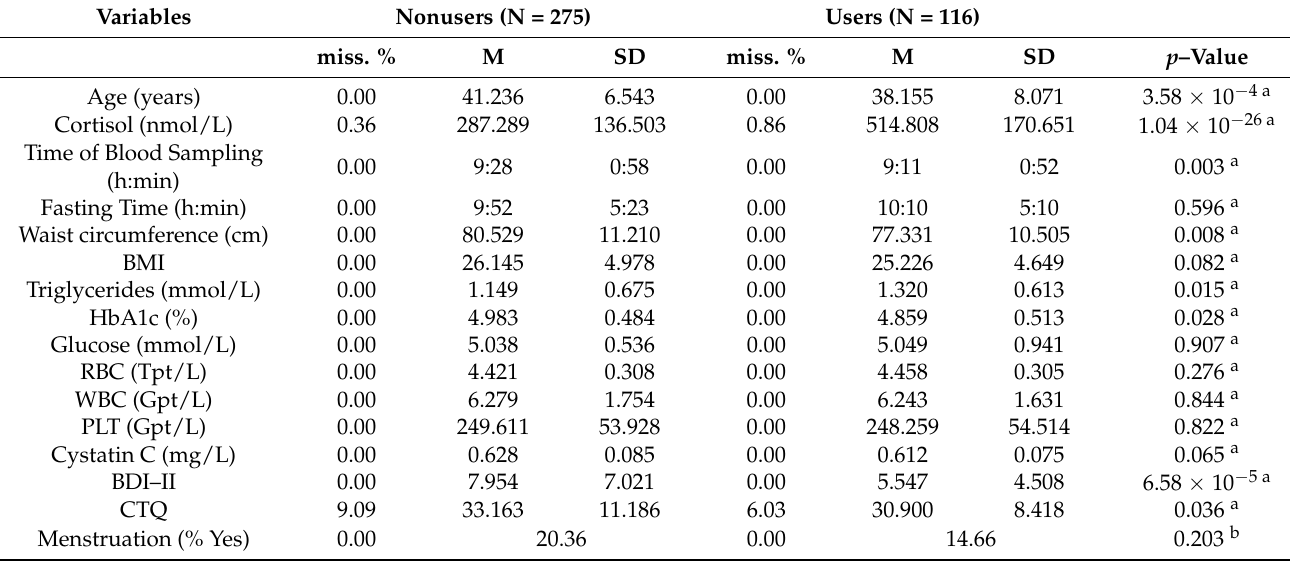
Table 2. Descriptive statistics of OC users and OC